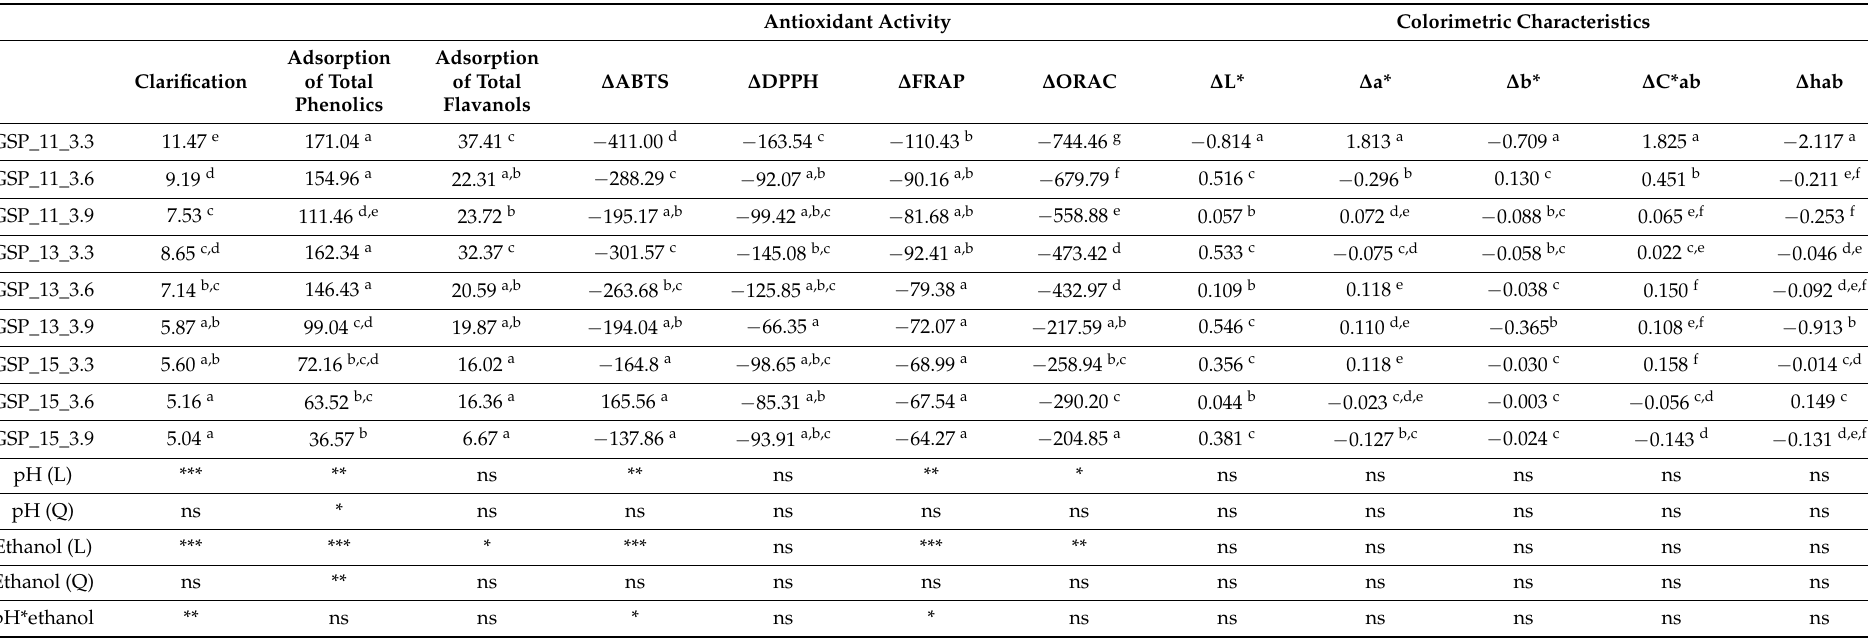
Table 3. Influence of wine pH (3.3, 3.6 and 3.9) and ethanol content (11, 13 and 15 % v / v ) on clarification (%, n = 3), adsorption of total phenolics (mg Eq